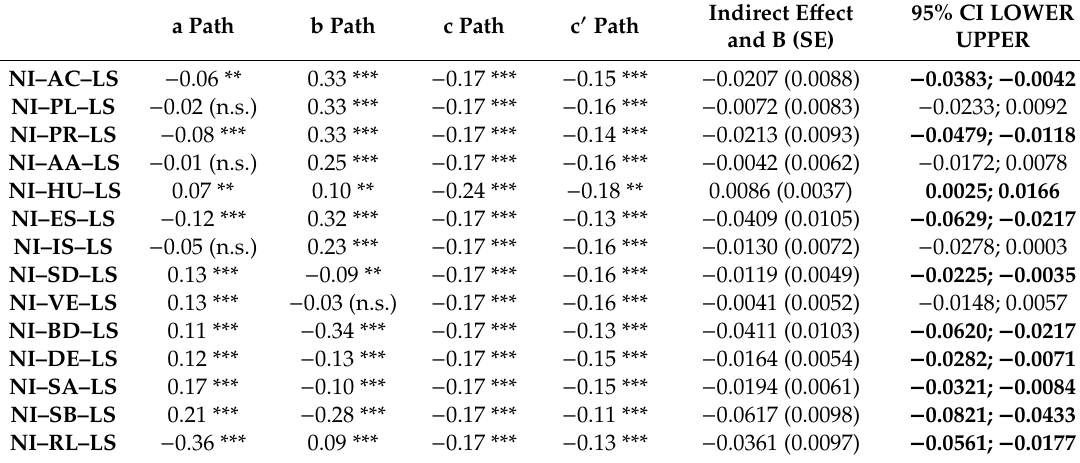
Table 6. The role of coping strategies on negative social interactions surrounding religion and life satisfaction (N =